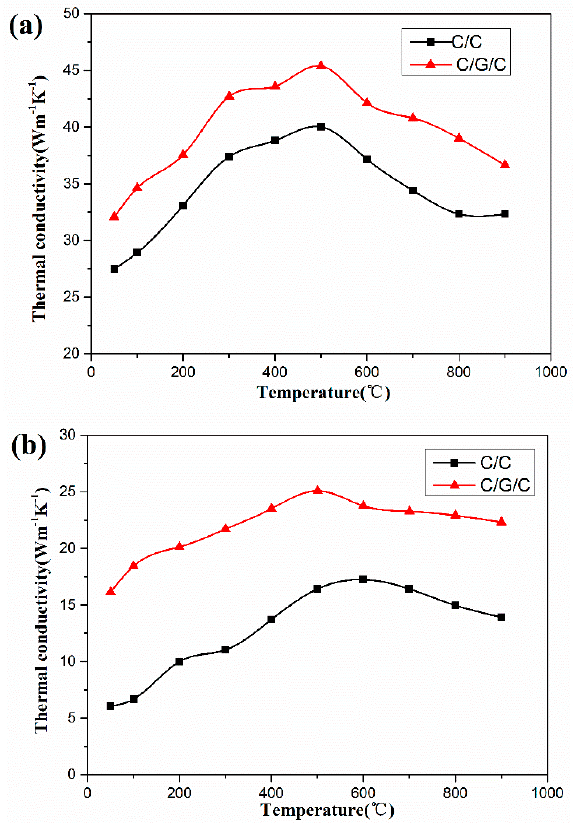
Figure 12. Thermal conductivity of C/C and C/G/C composites in the ( a ) X – Y and ( b ) Z directions.